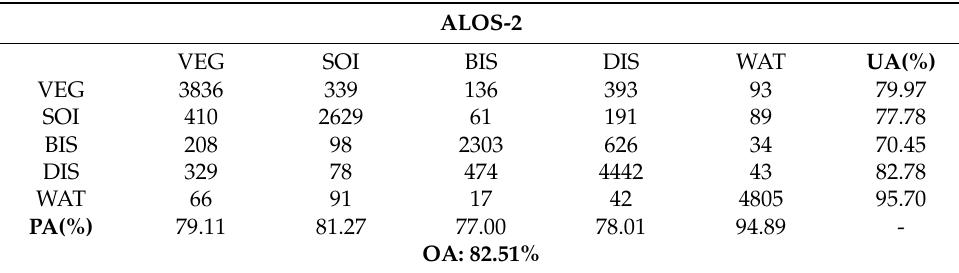
Table 2. The confusion matrix of testing samples with single SAR features. Columns represent classification labels, and rows represent the actual labels of the testing